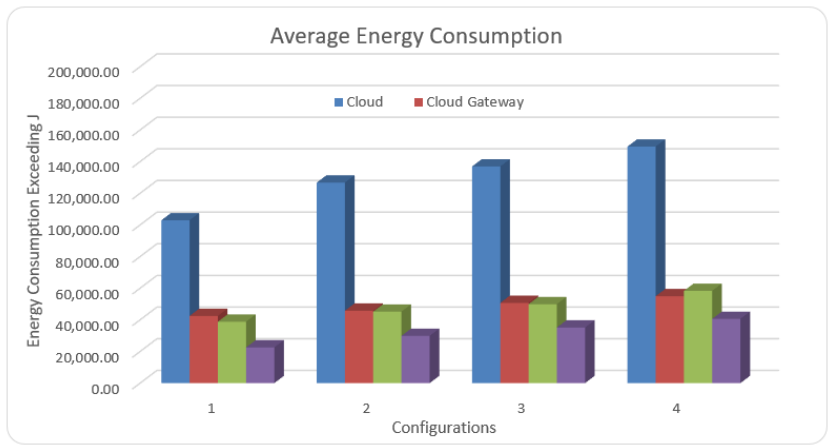
Figure 8. Average energy consumption